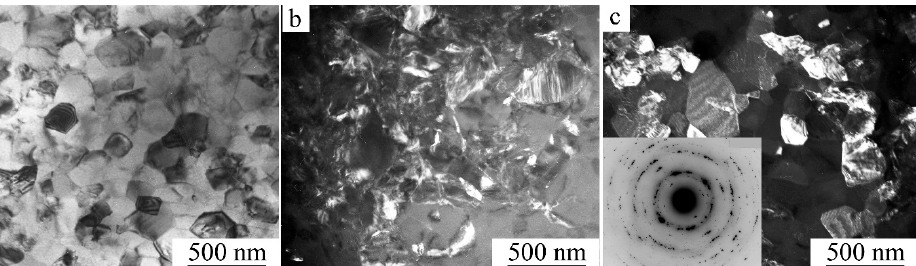
Figure 27. ( a ) Bright- and ( b , c ) dark-field TEM images, and the SAED pattern (( c ), insert—SD 1.0 µm), of the microstructure of the Ti 49 Ni 51 alloy after MPR by 30% and PDHT at 873 К for 1